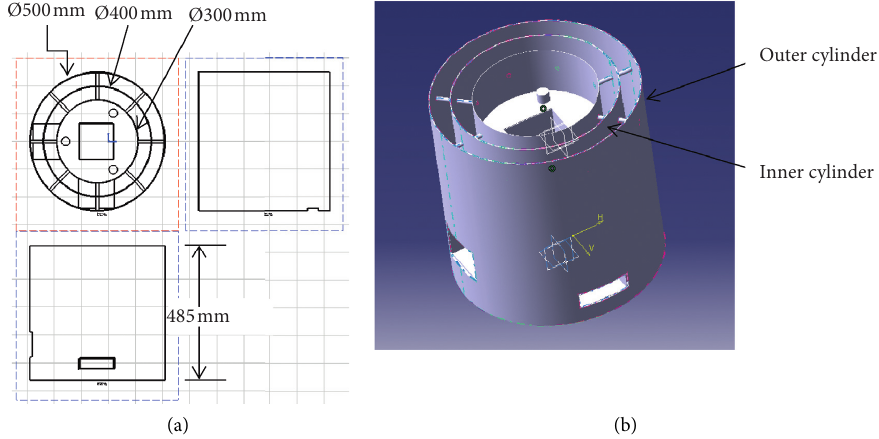
Figure 3: Components of the proposed stove: (a) drawing (dimensions) and (b) artistic impression.